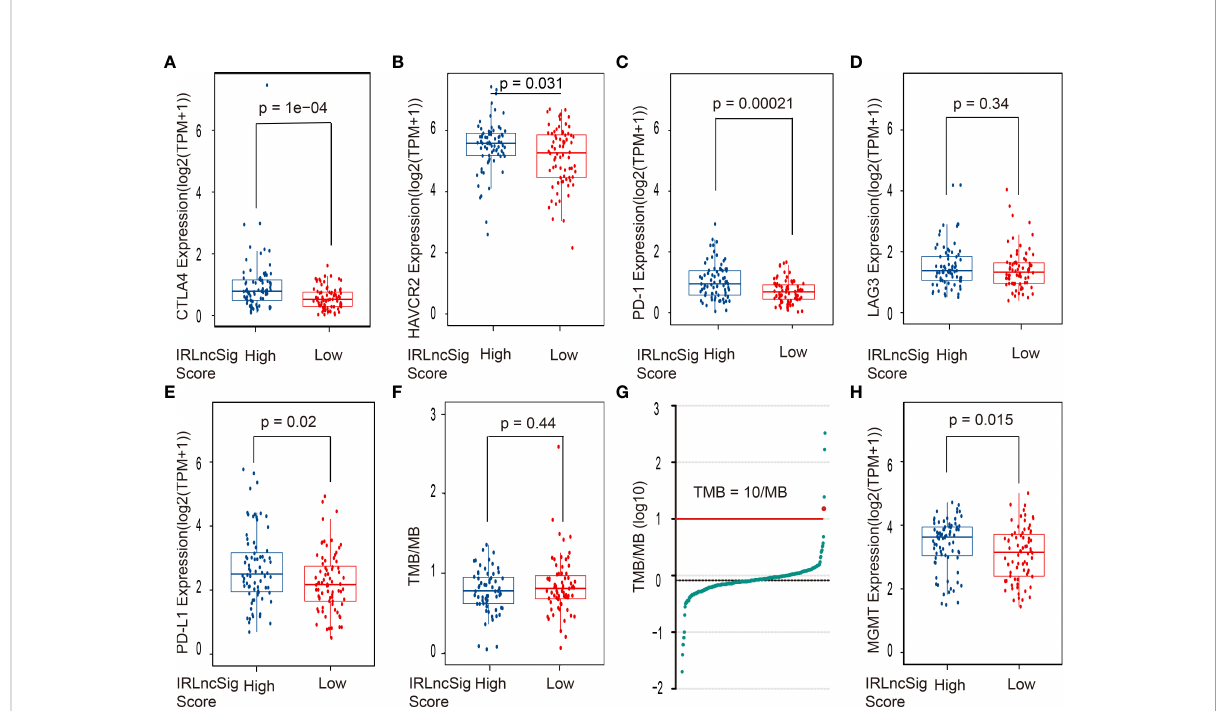
FIGURE 4 The correlation between the ICI biomarkers, the MGMT gene, TMB, and the risk assessment model. The high-IRLncSig-score group had signi fi cantly higher expression of (A) CTLA4, (B) HAVCR2, and (C) PD-1 but not (D) LAG3. (E) PD-L1 expression was higher in the High-IRLncSig- score group than in the low-IRLncSig-score group. (F, G) TMB does not have signi fi cant differences between the two groups and is lower than 10/MB in most cases. (H) The low-IRLncSig-score group was associated with lower expression of the MGMT gene. ICI biomarkers, immune checkpoint inhibitor biomarkers; MGMT, O6-methylguanine-DNA methyltransferase; TMB, tumor mutation burden; IRLncSig, immune-related lncRNA signature; CTLA4, cytotoxic T-lymphocyte-associated antigen-4; HAVCR2, hepatitis A virus cellular receptor 2; PD-1, antiprogrammed cell death protein-1; LAG3, lymphocyte activation gene 3 protein; PD-L1, programmed death